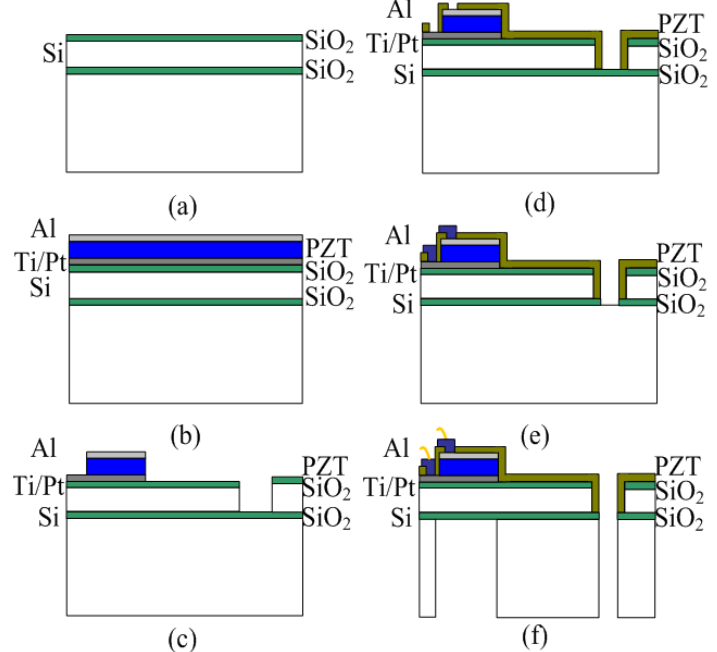
Figure 8. Fabrication process of MEMS piezoelectric energy